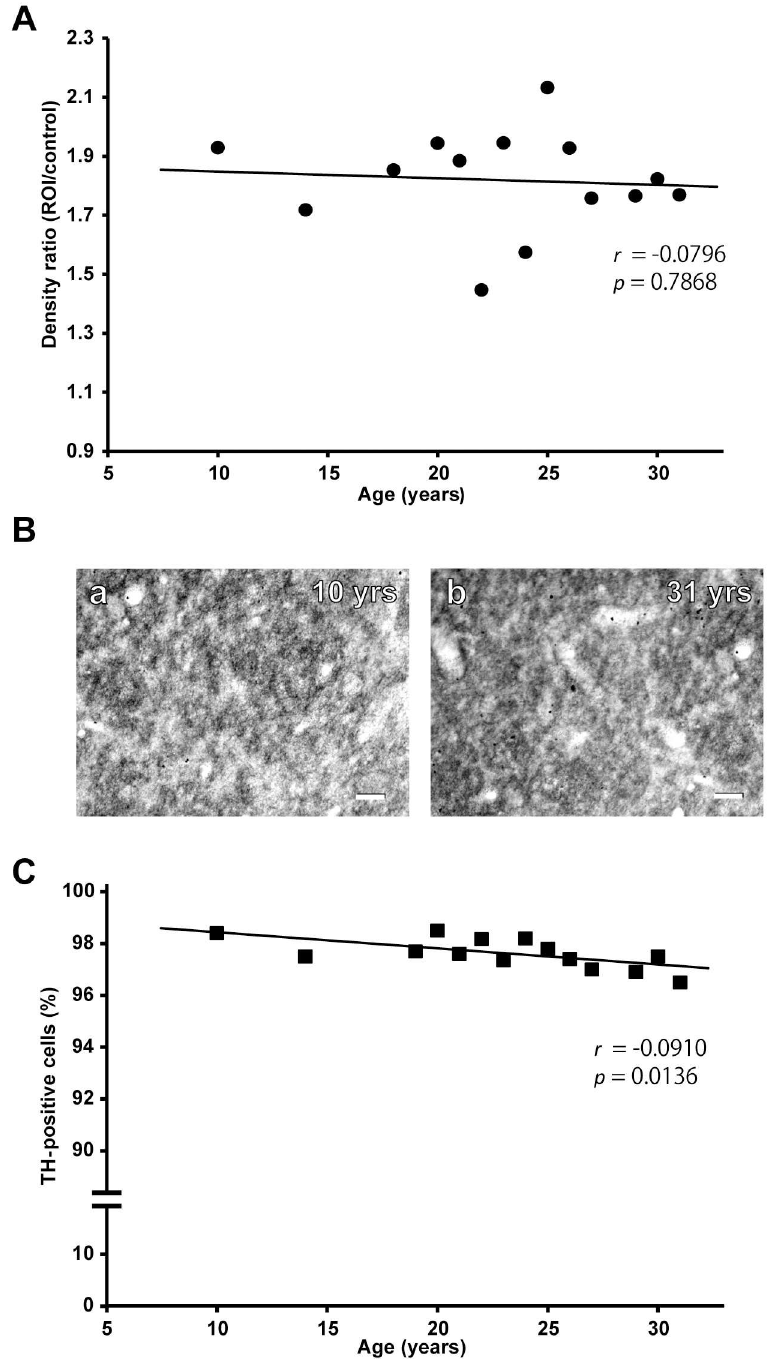
Fig 5. Age-dependent changes in striatal DAT immunoreactivity and nigral TH-positive neurons. A: Age-dependent change in DAT immunoreactivity in the striatum. The density ratio was measuredin comparisonwith background staining in the internalcapsule as a control. B: Photomicrographsof DAT immunostaining in the striatum at 10 (a) and 31 (b) years (yrs) of age. Scale bars, 50 μ m. C: Age-dependent changein the ratio of TH-positive neuronsto NeuN-positive neuronsin the SNc. Data are obtainedfrom doubleimmunofluorescence staining for TH and NeuN. See the text for methodological